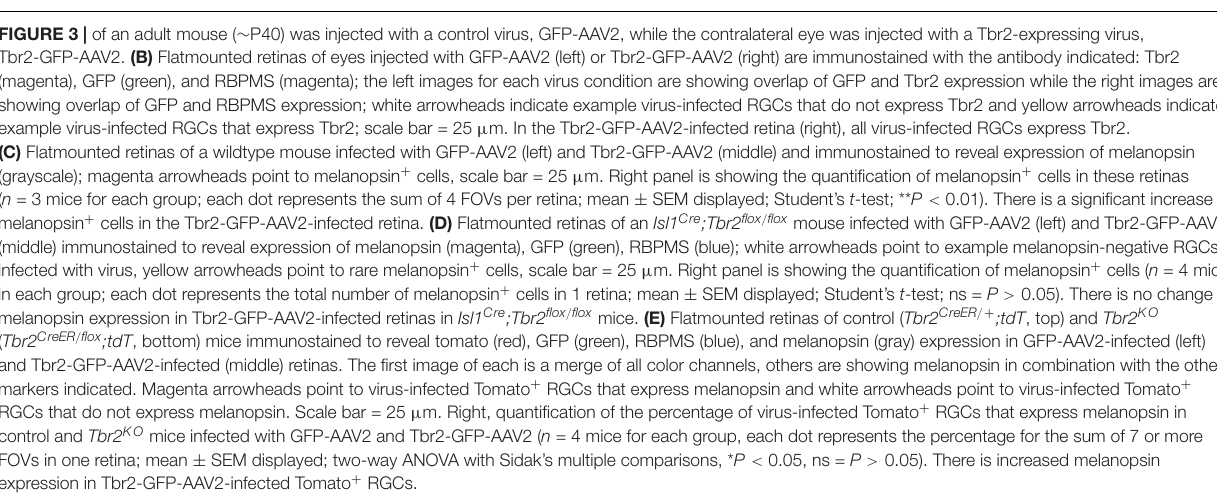
FIGURE 3 | of an adult mouse ( ∼ P40) was injected with a control virus, GFP-AAV2, while the contralateral eye was injected with a Tbr2-expressing virus, Tbr2-GFP-AAV2. (B) Flatmounted retinas of eyes injected with GFP-AAV2 (left) or Tbr2-GFP-AAV2 (right) are immunostained with the antibody indicated: Tbr2 (magenta), GFP (green), and RBPMS (magenta); the left images for each virus condition are showing overlap of GFP and Tbr2 expression while the right images are showing overlap of GFP and RBPMS expression; white arrowheads indicate example virus-infected RGCs that do not express Tbr2 and yellow arrowheads indicate example virus-infected RGCs that express Tbr2; scale bar = 25 µ m. In the Tbr2-GFP-AAV2-infected retina (right), all virus-infected RGCs express Tbr2. (C) Flatmounted retinas of a wildtype mouse infected with GFP-AAV2 (left) and Tbr2-GFP-AAV2 (middle) and immunostained to reveal expression of melanopsin (grayscale); magenta arrowheads point to melanopsin + cells, scale bar = 25 µ m. Right panel is showing the quantification of melanopsin + cells in these retinas ( n = 3 mice for each group; each dot represents the sum of 4 FOVs per retina; mean ± SEM displayed; Student’s t -test; ** P < 0.01). There is a significant increase in melanopsin + cells in the Tbr2-GFP-AAV2-infected retina. (D) Flatmounted retinas of an Isl1 Cre ;Tbr2 flox / flox mouse infected with GFP-AAV2 (left) and Tbr2-GFP-AAV2 (middle) immunostained to reveal expression of melanopsin (magenta), GFP (green), RBPMS (blue); white arrowheads point to example melanopsin-negative RGCs infected with virus, yellow arrowheads point to rare melanopsin + cells, scale bar = 25 µ m. Right panel is showing the quantification of melanopsin + cells ( n = 4 mice in each group; each dot represents the total number of melanopsin + cells in 1 retina; mean ± SEM displayed; Student’s t -test; ns = P > 0.05). There is no change in melanopsin expression in Tbr2-GFP-AAV2-infected retinas in Isl1 Cre ;Tbr2 flox / flox mice. (E) Flatmounted retinas of control ( Tbr2 CreER / + ;tdT , top) and Tbr2 KO ( Tbr2 CreER / flox ;tdT , bottom) mice immunostained to reveal tomato (red), GFP (green), RBPMS (blue), and melanopsin (gray) expression in GFP-AAV2-infected (left) and Tbr2-GFP-AAV2-infected (middle) retinas. The first image of each is a merge of all color channels, others are showing melanopsin in combination with the other markers indicated. Magenta arrowheads point to virus-infected Tomato + RGCs that express melanopsin and white arrowheads point to virus-infected Tomato + RGCs that do not express melanopsin. Scale bar = 25 µ m. Right, quantification of the percentage of virus-infected Tomato + RGCs that express melanopsin in control and Tbr2 KO mice infected with GFP-AAV2 and Tbr2-GFP-AAV2 ( n = 4 mice for each group, each dot represents the percentage for the sum of 7 or more FOVs in one retina; mean ± SEM displayed; two-way ANOVA with Sidak’s multiple comparisons, * P < 0.05, ns = P > 0.05). There is increased melanopsin expression in Tbr2-GFP-AAV2-infected Tomato +